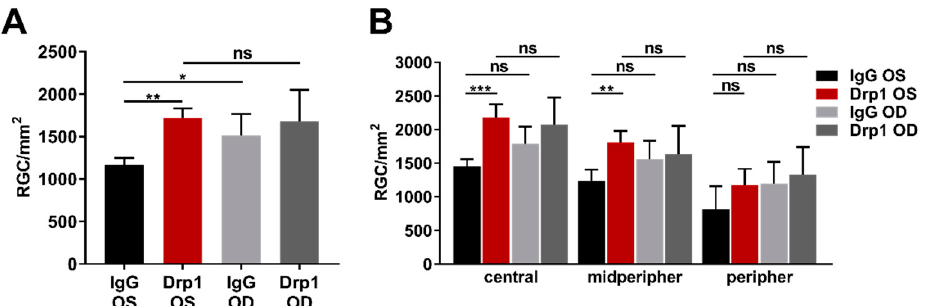
Figure 2. Quantitative analysis of Brn3 + RGCs in retinal flatmounts. Retinal ganglion cells were stained using immunostaining of Brn3a. An anti-Brn3a antibody (C20, Santa Cruz, Dallas, TX, USA) was used as the primary antibody and an anti-goat AF568 antibody (Life Technologies, Carlsbad, CA, USA) as the secondary antibody. Single images were taken with a fluorescence microscope (Eclipse TS 100 microscope, Nikon, Yurakucho, Tokyo, Japan), DS-Fi1-U2 digital microscope camera (Nikon, Tokyo, Japan). Objective: ELWD 20 × /0.45 S Plan Flour Ph1 ADM Air objective (Nikon, Tokyo, Japan). ( A ) Nine images were taken from each flatmount. The RGC number was determined for each image. The average RGC number of the whole flatmount was calculated over all nine images. ( B ) Three of the total nine images were taken for each of the areas central, mid-peripheral, peripheral. For each area, the average RGC density was calculated over the three recordings of one area. * p < 0.05, ** p < 0.01, *** p < 0.001, ns = not significant, One-way ANOVA, Tukey’s HSD test (post hoc). Numbers of animals used: n = 7 (IgG), n = 8